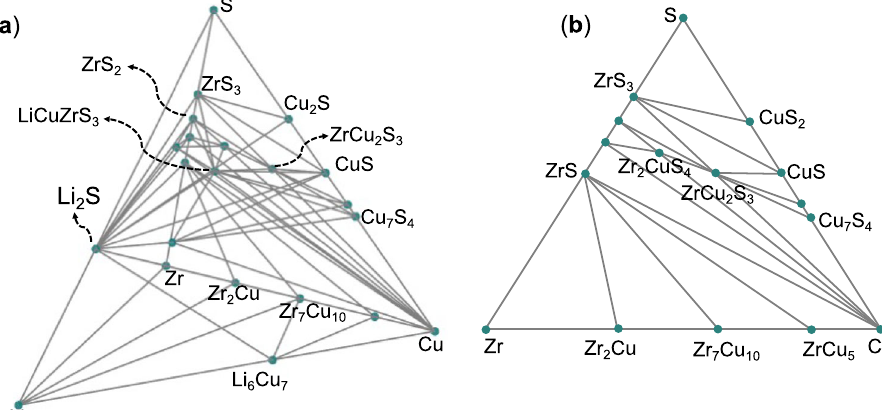
Fig. 7 Visualization of quaternary and ternary phase diagrams. a The four-dimensional phase diagram (T = 0 K) of the Li-Cu-Zr-S quaternary system, which is the isometric shot of a Gibbs ’ tetrahedron. b One of the faces of the tetrahedron represents the three-dimensional phase diagram of the Cu-Zr-S ternary system which is presented as the Gibbs ’ triangle. Each cyan node in a and b represents a stable compound. For clarity, we do not show any metastable/unstable compounds and mark only few stable compounds in this fi gure. LiCuZrS 3 is one of the predicted stable compounds in this work, which and its competing phases are denoted with dashed arrows in a